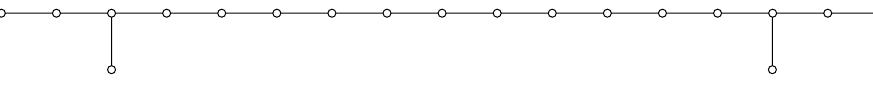
Figure 1. The Coxeter pyramid P ∗ ⊂ H 17